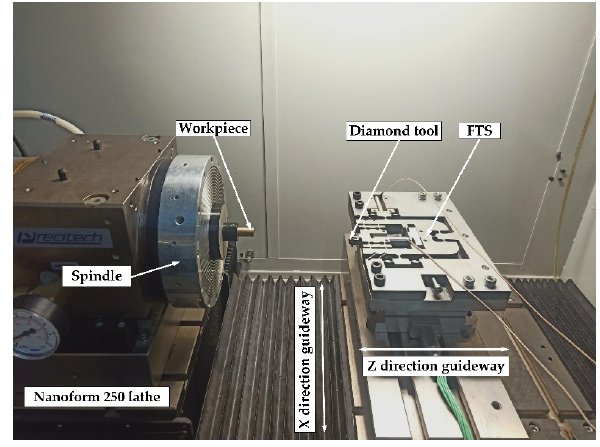
Figure 21. Experimental setup for the cutting.